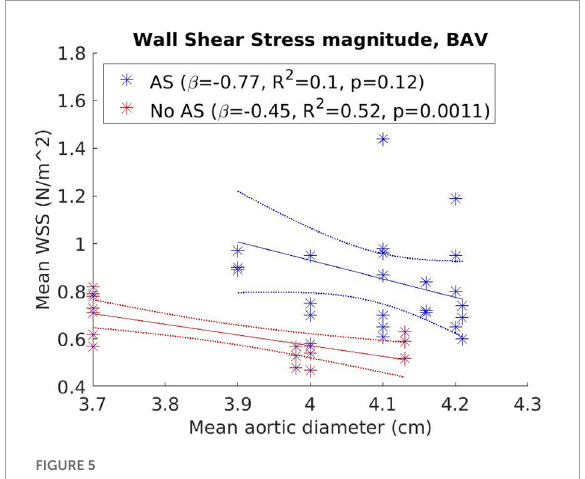
FIGURE5 Correlation between wall shear stress magnitude (WSS mag ) and aortic diameter in bicuspid aortic valve (BAV) cohorts with or without aortic stenosis with results from weighted linear regression also